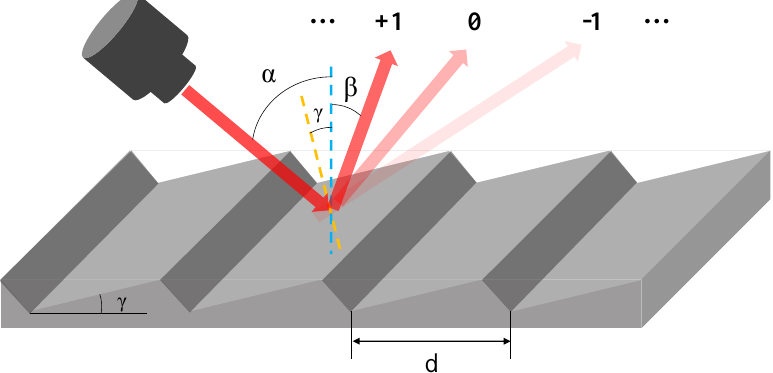
Figure 1. Schematic and optical path diffraction of a blazed grating. The monochromatic light obliquely incident on the blazed grating, and then it is diffracted into discrete directions. Each grating profile can be considered to be a small, slit-shaped source of diffracted light that combines to form a set of diffracted wave fronts. Because the diffracted lights from different grating surfaces have the same phase, thus resulting in constructive interference. The relationships of incident angle α , diffraction angle β , grating constant d and the incident light wavelength λ are given by the diffraction grating equation, as shown in Equation